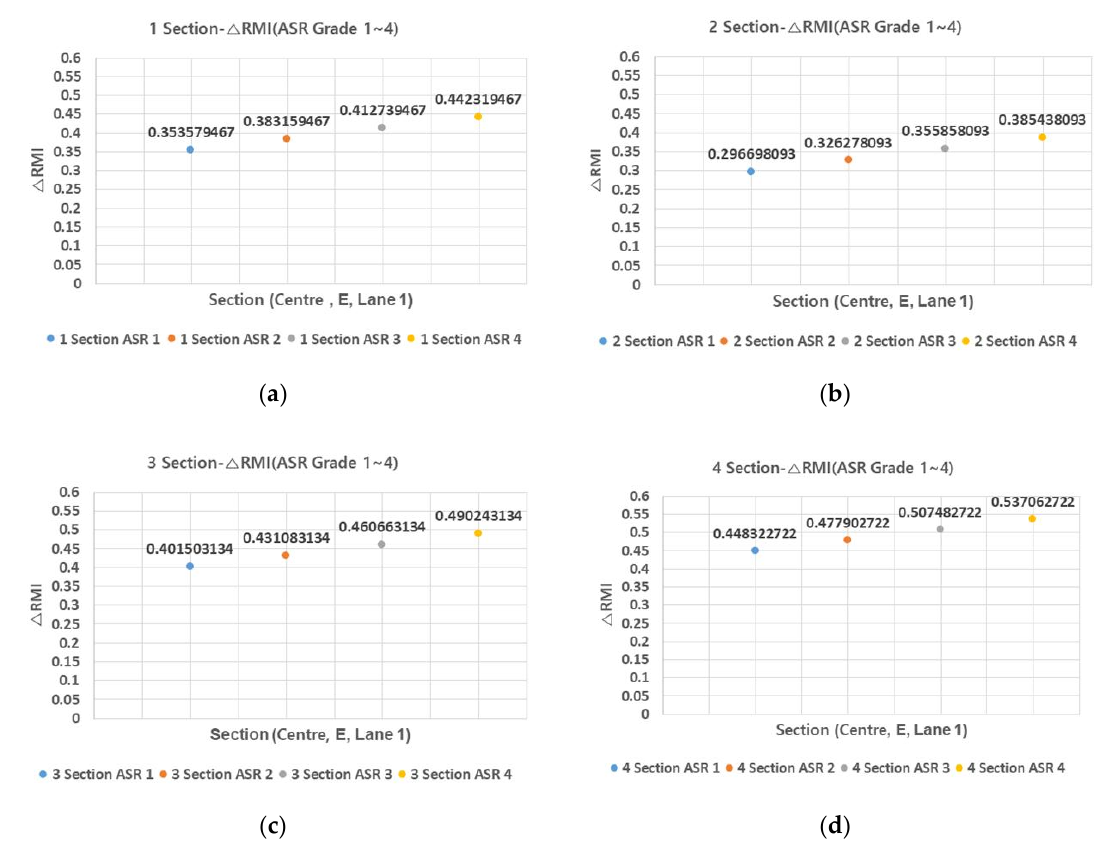
Figure 5. Section–ΔRMI relationship (ASR grade 1–4) ( a ) 1 section; ( b ) 2 section; ( c ) 3 section; and ( d ) 4 section.